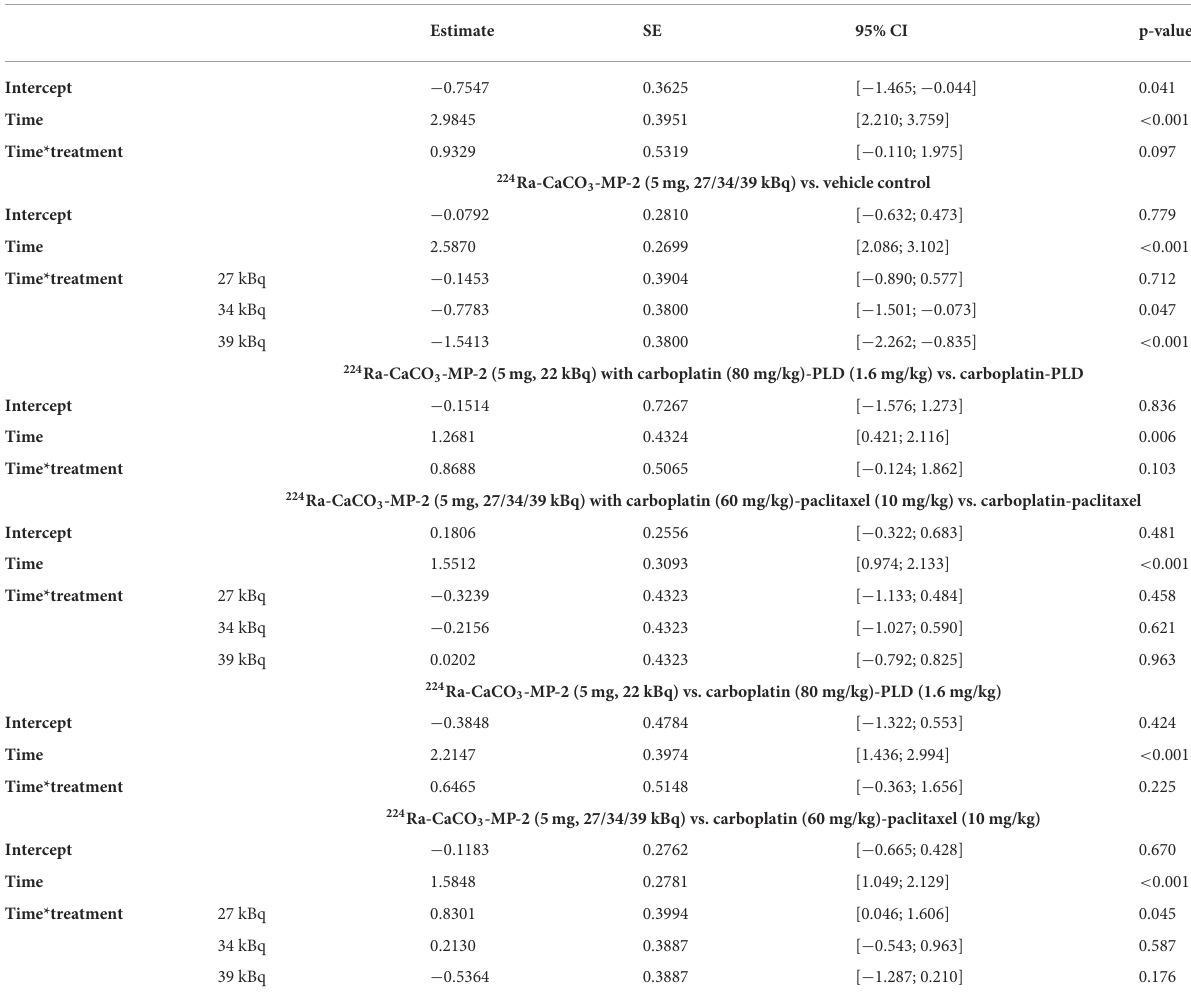
TABLE 4 Overview of weight change assessment in mice that received 224 Ra-CaCO 3 -MPs as a single treatment and in combination with both carboplatin-paclitaxel and carboplatin-PLD chemotherapy